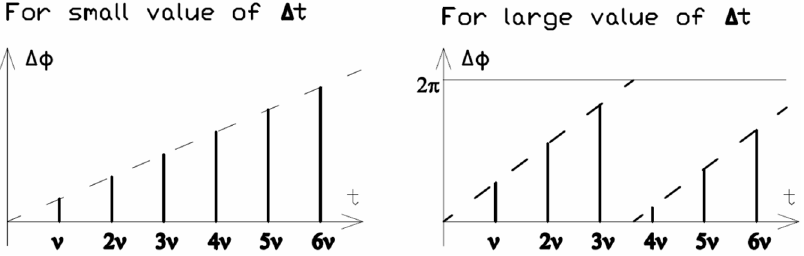
Figure 6. Graph of phase spectrum difference from two sensors.